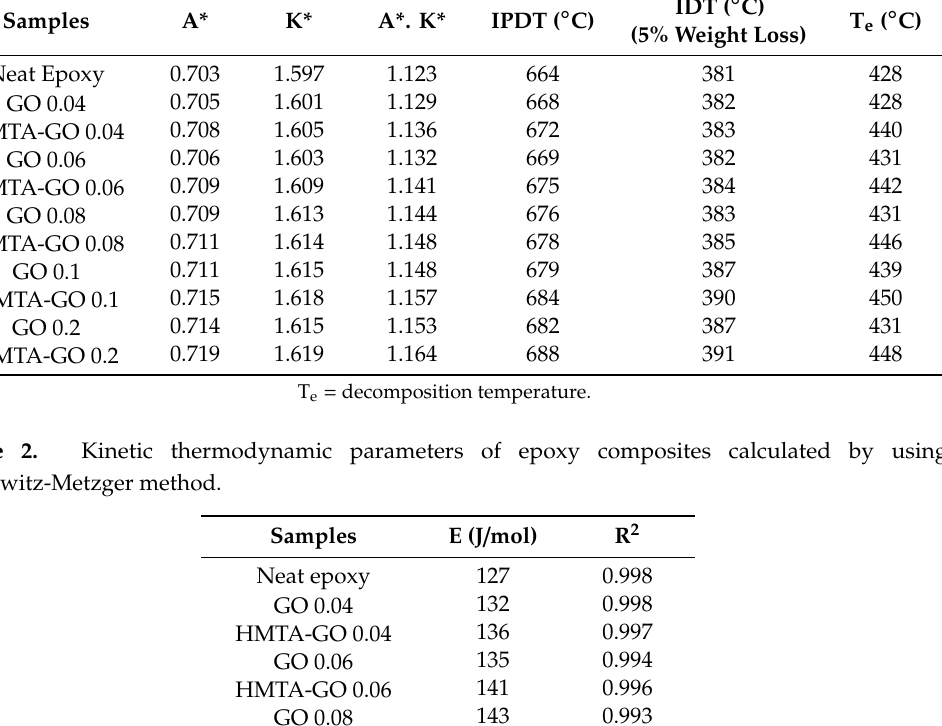
Table 1. Kinetic thermodynamic parameters of epoxy composites obtained by TGA thermograms. Samples